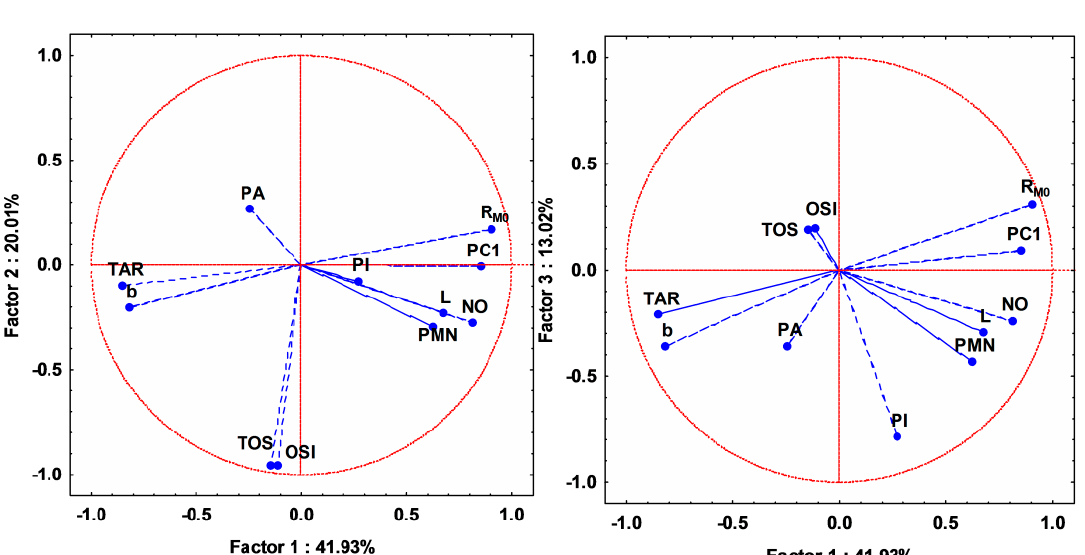
index; NO = nitric oxide; TOS = total oxidative status; TAR = total antioxidant response; OSI = oxidative stress index; R M0 = lipophilicity estimation parameter; b = slope; PC1 = first principal component.